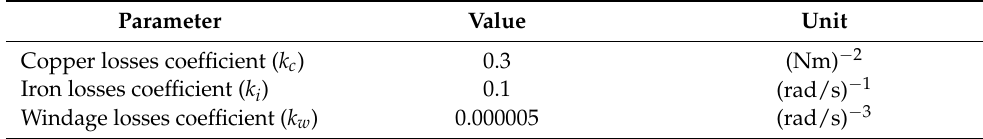
Table 2. Electric motor